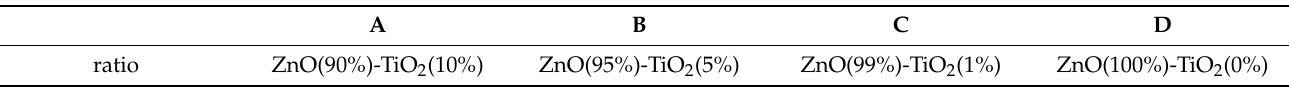
Figure 2. The overall experimental process. Table 1. ZnO-TiO 2 gas sensor